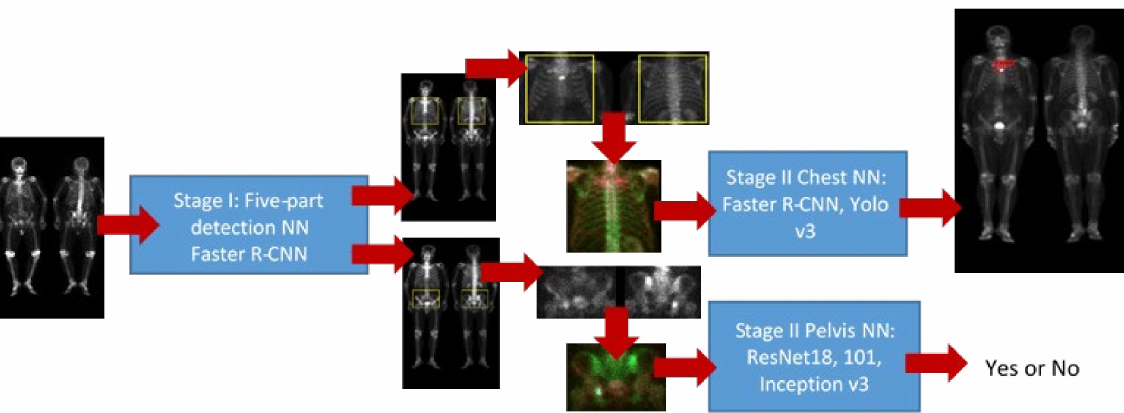
Figure 5. Combined structure of all the NNs used in this study. The structure comprises two stages. Scheme 3. Results.